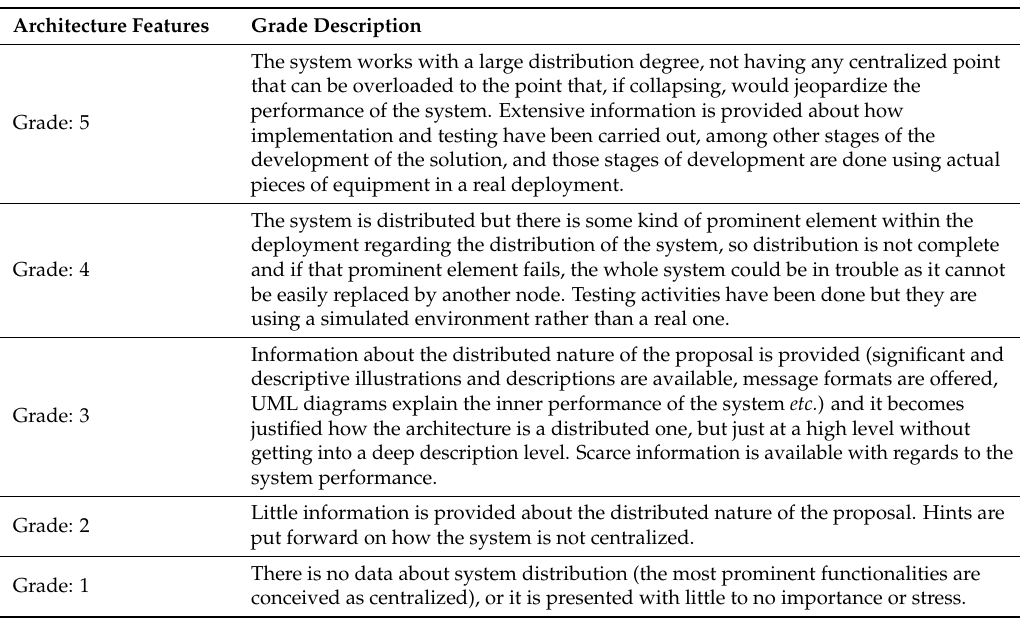
Table 2. System distribution